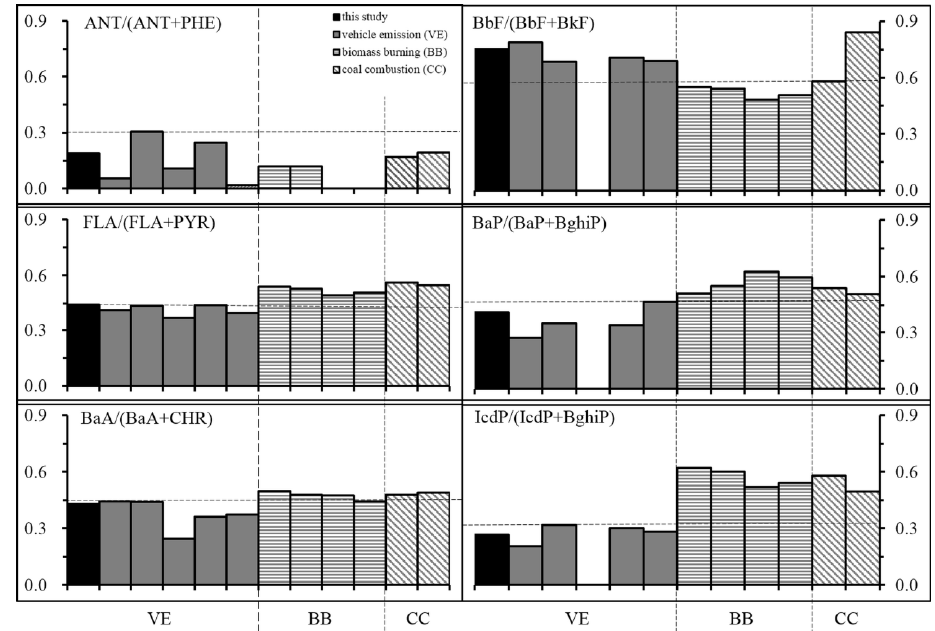
Figure 2. ANT / (ANT + PHE), FLA / (FLA + PYR), BaA / (BaA + CHR), BbF / (BbF + BkF), BaP / (BaP + BghiP) and IcdP / (IcdP + BghiP) ratios for three source emissions. ANT: anthracene, PHE: phenanthrene, FLA: fluoranthene, PYR: pyrene, BaA: benz[a]anthracene, CHR: chrysene, BbF: benzo[b]fluoranthene, BkF: benzo[k]fluoranthene, BaP: benzo[a]pyrene, BghiP: benzo[ghi]perylene, IcdP: indeno[cd]pyrene. The vehicle emission composition is from data collected in roadway tunnels (this